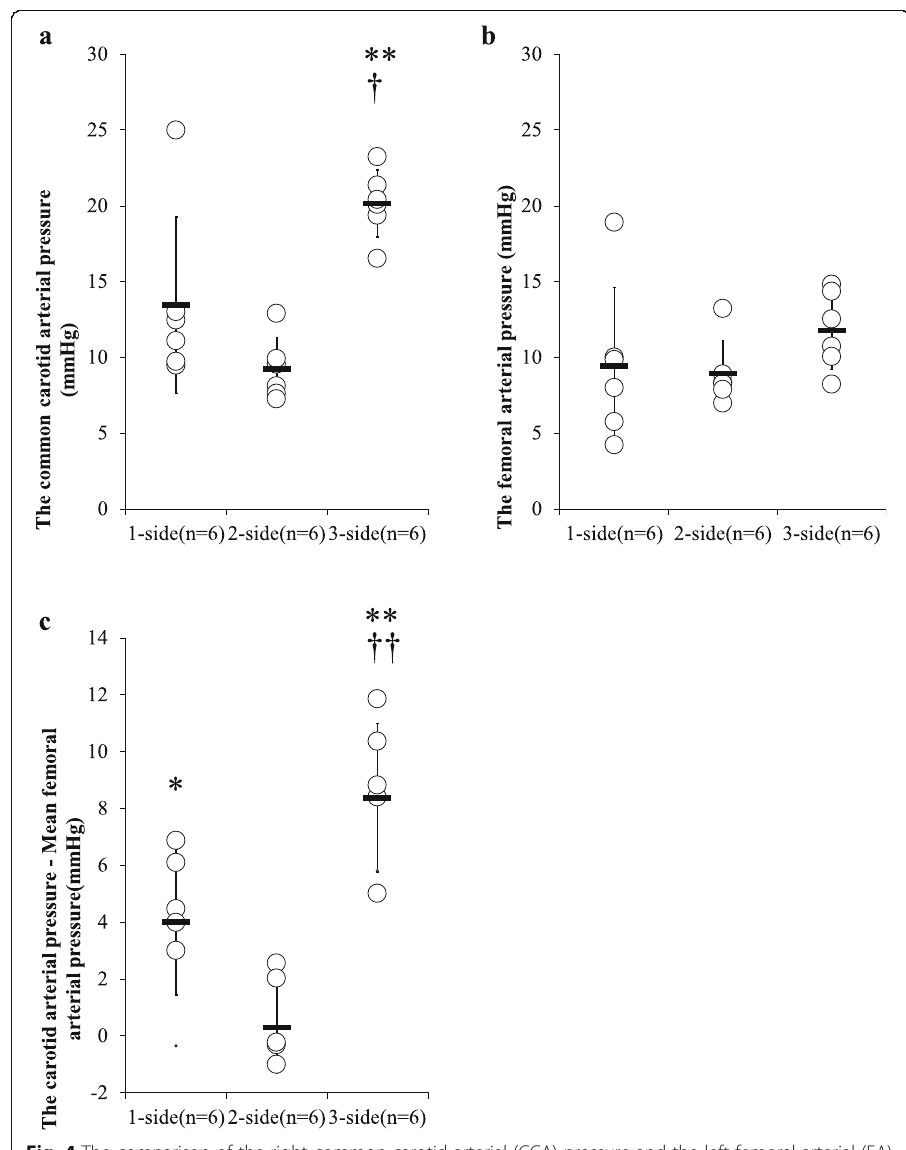
no negative pressure was generated during the decompression phase of CPR with some negative effect on hemodynamic. However, it has been widely accepted that simultan- eous chest compression and ventilation at high airway pressure improves the systemic arterial pressure in humans [17, 18] and experimental models [19]. An open airway limits the effect of the thoracic pump [8] as the pressure measured in the airway be- comes equal to the atmospheric pressure. In our experimental setting, the ventilation system was used with a closed circuit. There was no synchronization of CPR with the ventilation cycles. The 3-side chest compression showed the highest airway pressure